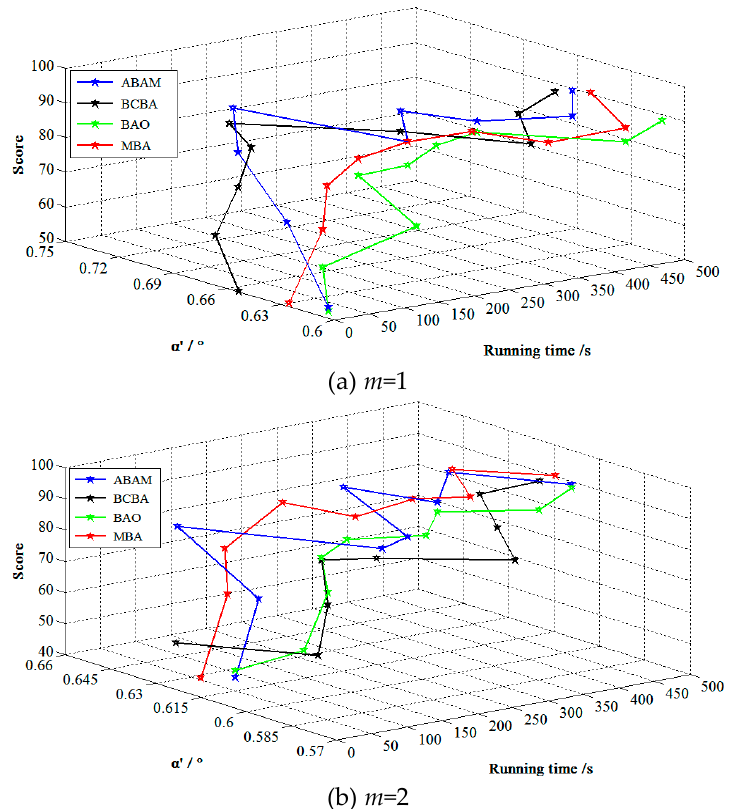
Figure 6. Optimal horizontal bending angle and corresponding score distribution map.